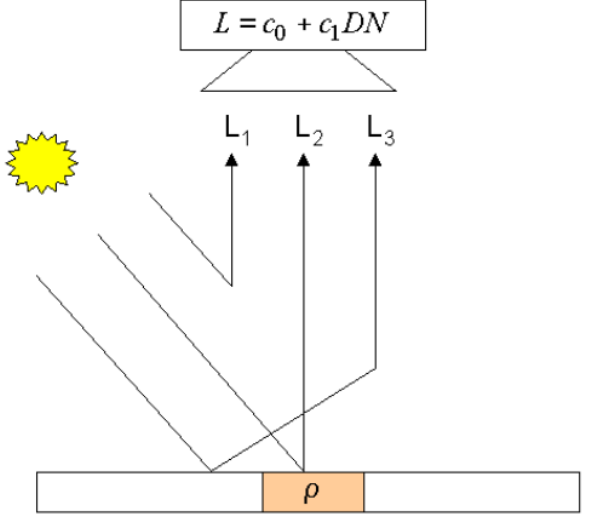
Figure 1. Schema of the solar radiative components (L i ) in a Lambertian